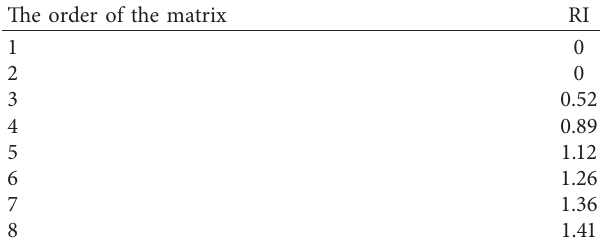
Table 1: RI values under different orders of judgment matrices. The order of the